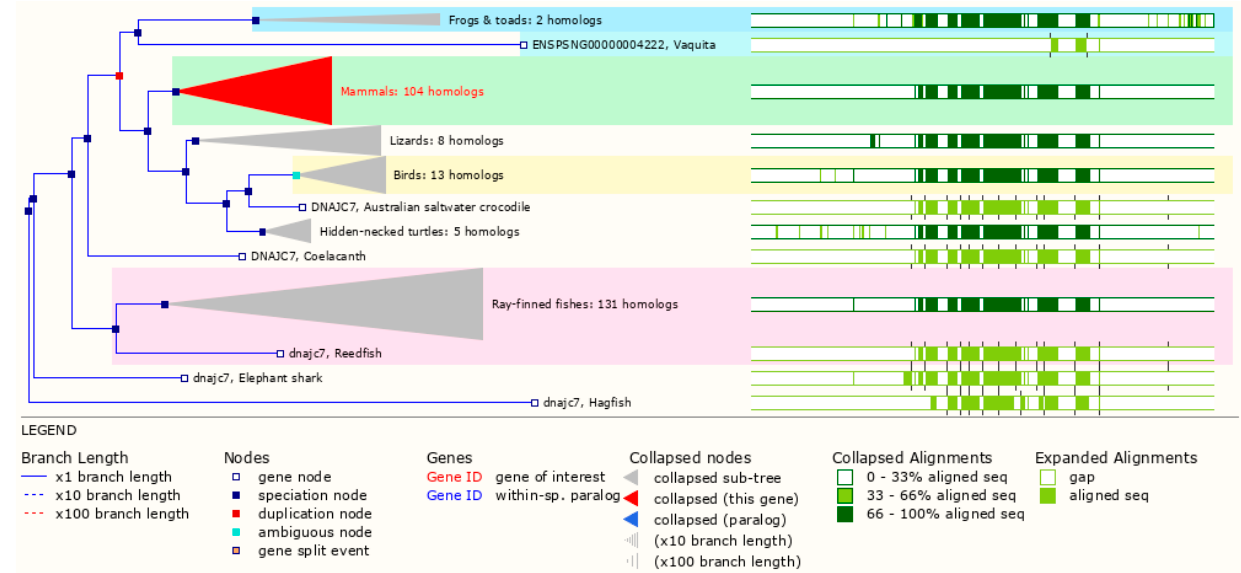
Figure 2. Phylogenetic tree of human DNAJC7 including protein sequence alignment. The single gene split event at P. reticulata is not shown. The phylogenetic tree was built using the Gene Tree application within the current release of Ensembl [30].